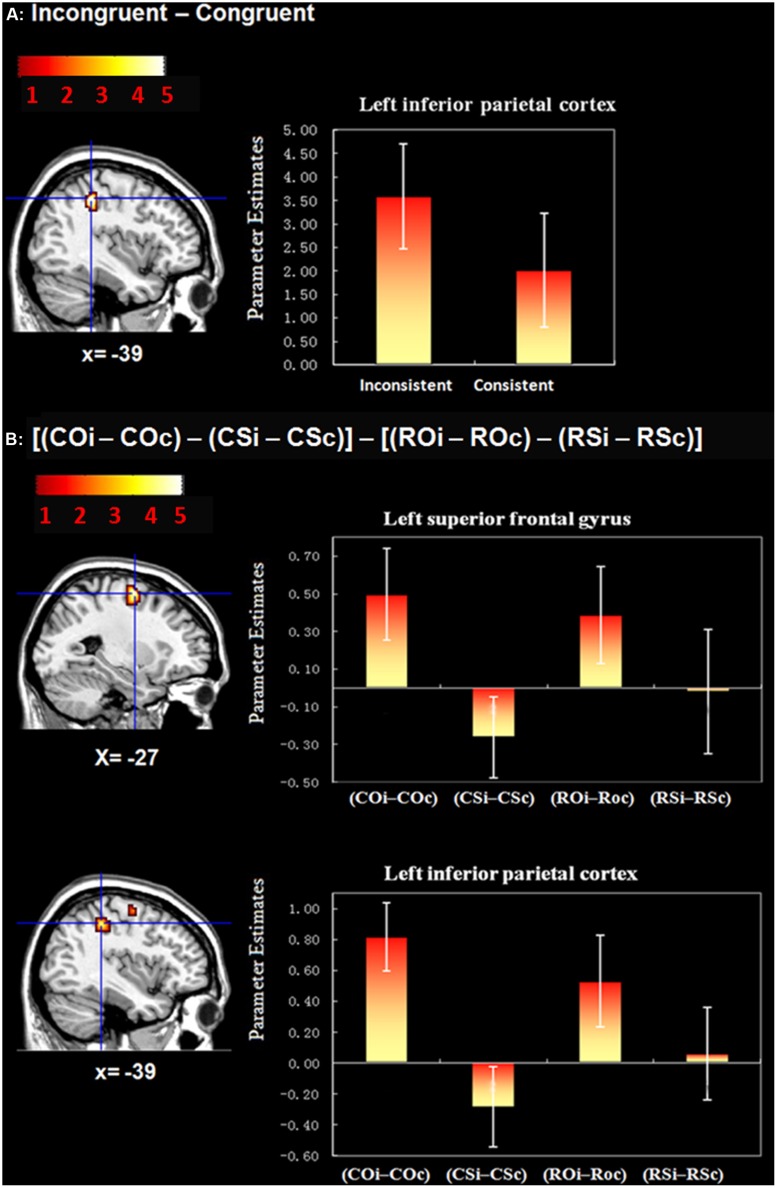
Whole brain activation during the flanker task. (A) Activation of the contrast “Incongruent–Congruent.” The left inferior parietal cortex (IPC) was found to exhibit greater activation; (B) Activation of the contrast “[(COi–COc) – (CSi–CSc)] – [(ROi–ROc) – (RSi–RSc)].” The left superior frontal gyrus (SFG) and IPC were found to exhibit greater activation in this contrast. Mean parameter estimates in each brain area for each contrastare shown. By using a leave-one-out-cross-validation (LOOCV) analysis (Kriegeskorte et al., 2009), the data used to define an regions of interest (ROI) and the data extracted from this ROI (activation in the bar graphs) are independent.